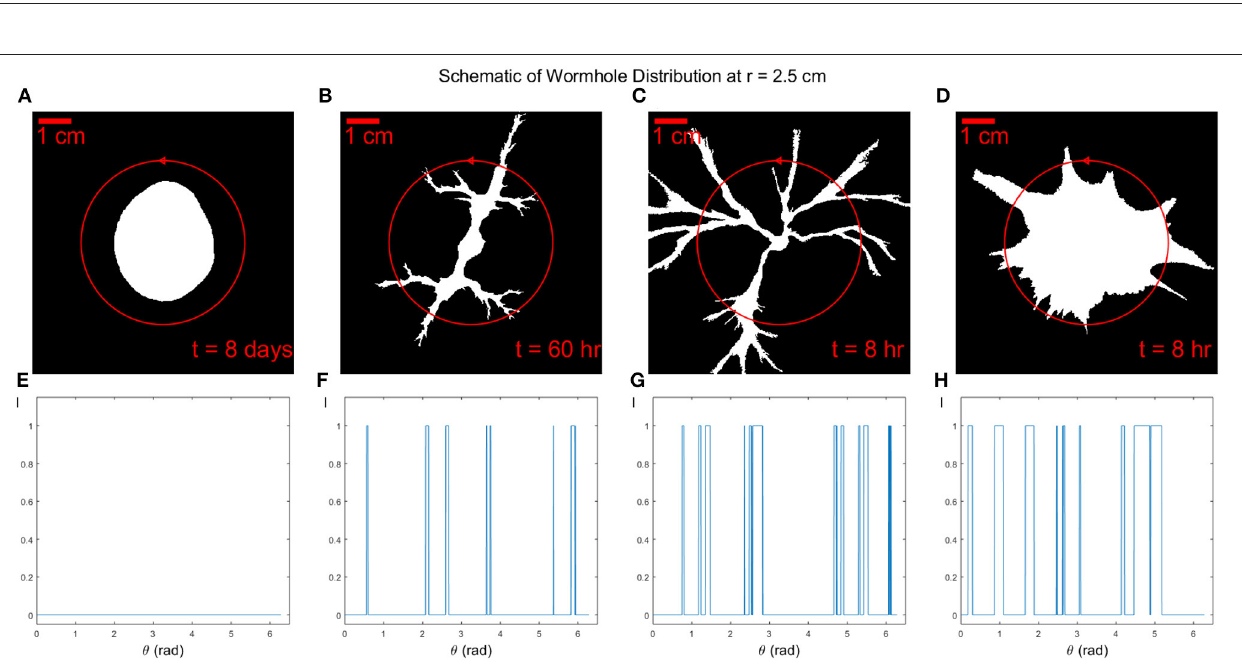
FIGURE 5 | Four binarized images (A–D) on the top show the dissolution patterns of experiments I1 to I4 with same aperture but different injection rate Q. The total dissolution time is t 8 days, t 60 h, t 8 h, and t 8 h, respectively. The red circle has a radius of r = = = = The circle is traversed in the counterclockwise direction, as marked by the arrow. Wormhole distributions are shown at the bottom (E–H) . Note that because the images are binarized, the intensity value I can be either 1 or 0. The number of wormholes can be counted as the number of peaks of the distribution with a minimum peak width 2 mm.